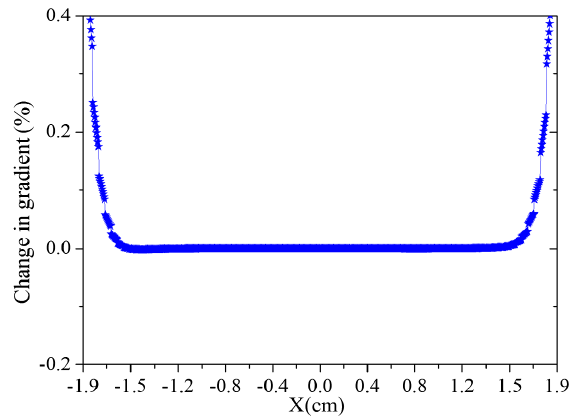
FIG. 19. Gradient uniformity of 0.1% is extended up to a radius of 1.78 cm, for the assembly of 24 PMs, which is called the radius of good field zone.